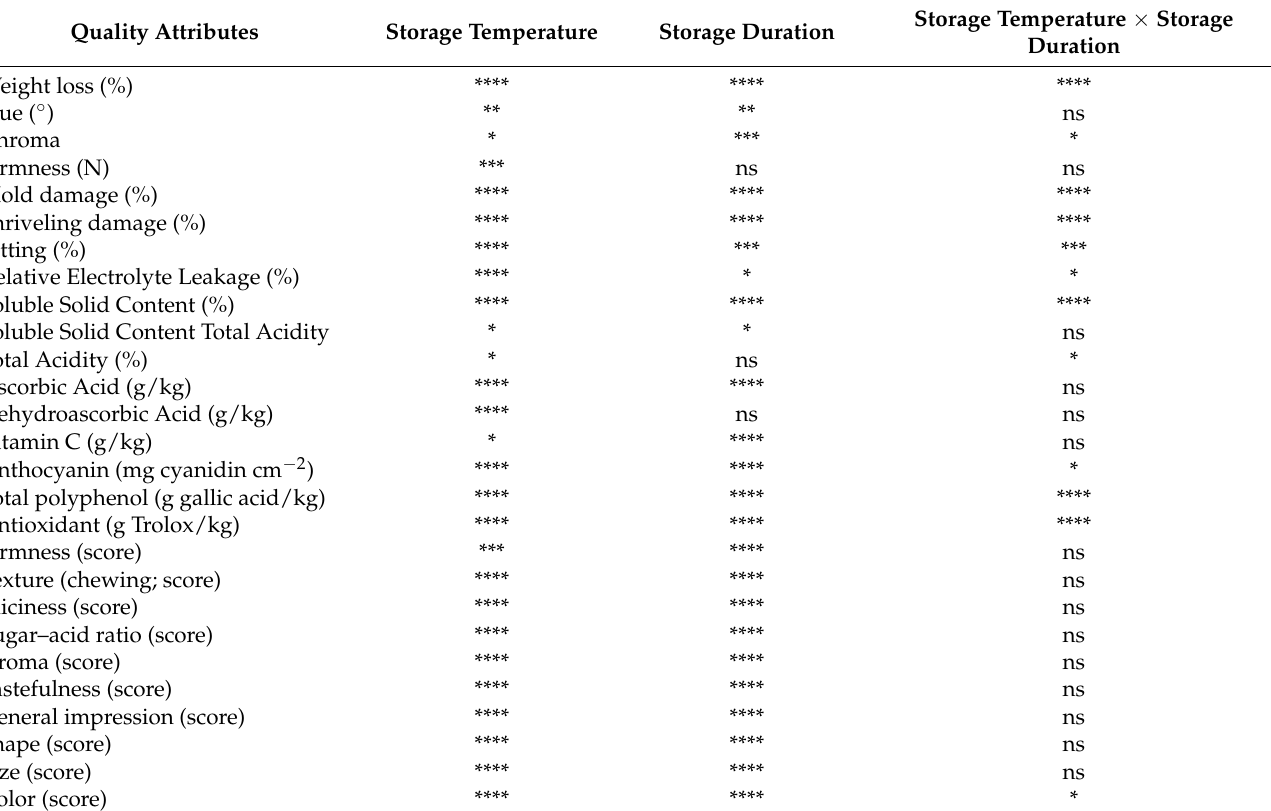
Table 1. Effect of storage temperature, storage duration, and interaction on quality attributes of goji berries stored for 12 days at 0, 5, and 7 ◦ C. Mean values of 12 samples are reported (three replicates × four storage